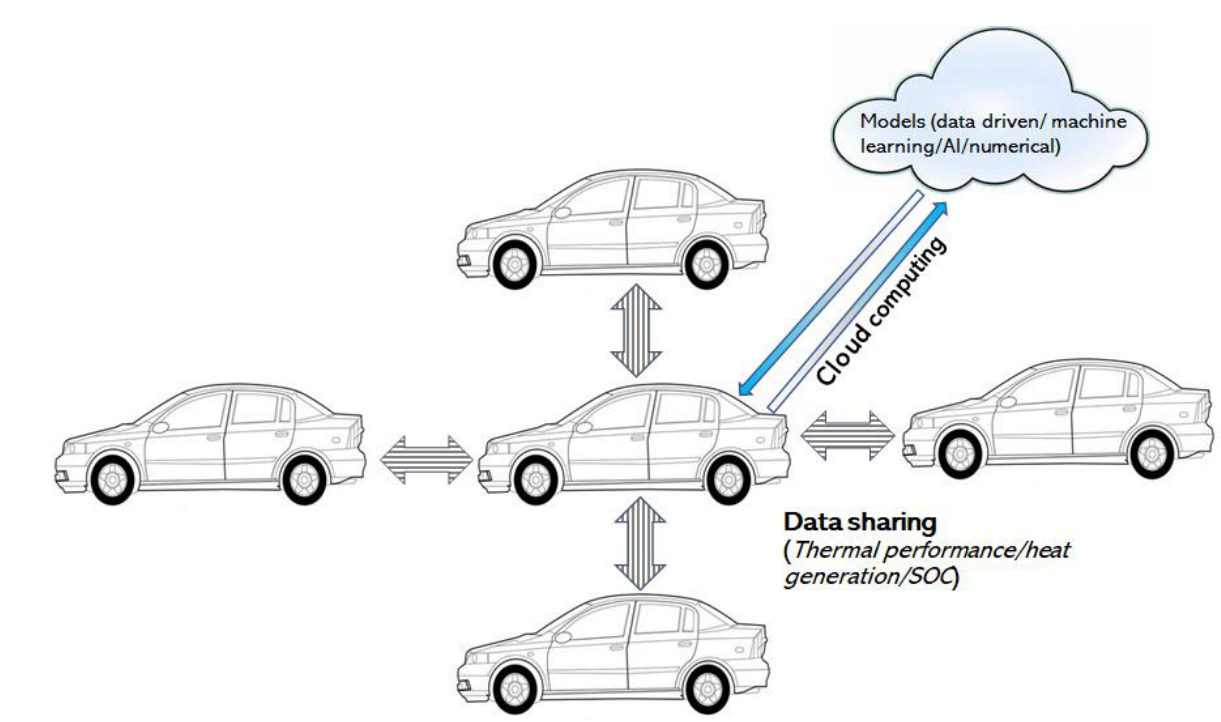
Figure 14. Schematic representation of a proposed IoT-cloud enabled structure that particularly could benefit big data and data-driven modeling-based BTMS approach for fast training, thermal performance optimization, and minimization of in-house computational efforts.